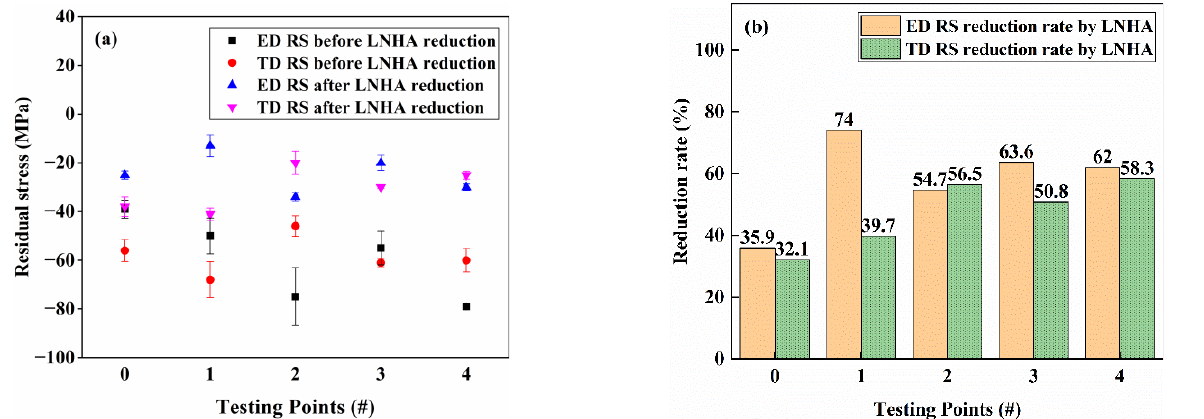
Figure 3. ( a ) ED and TD residual stress and ( b ) relief rate at different points treated by LNB.